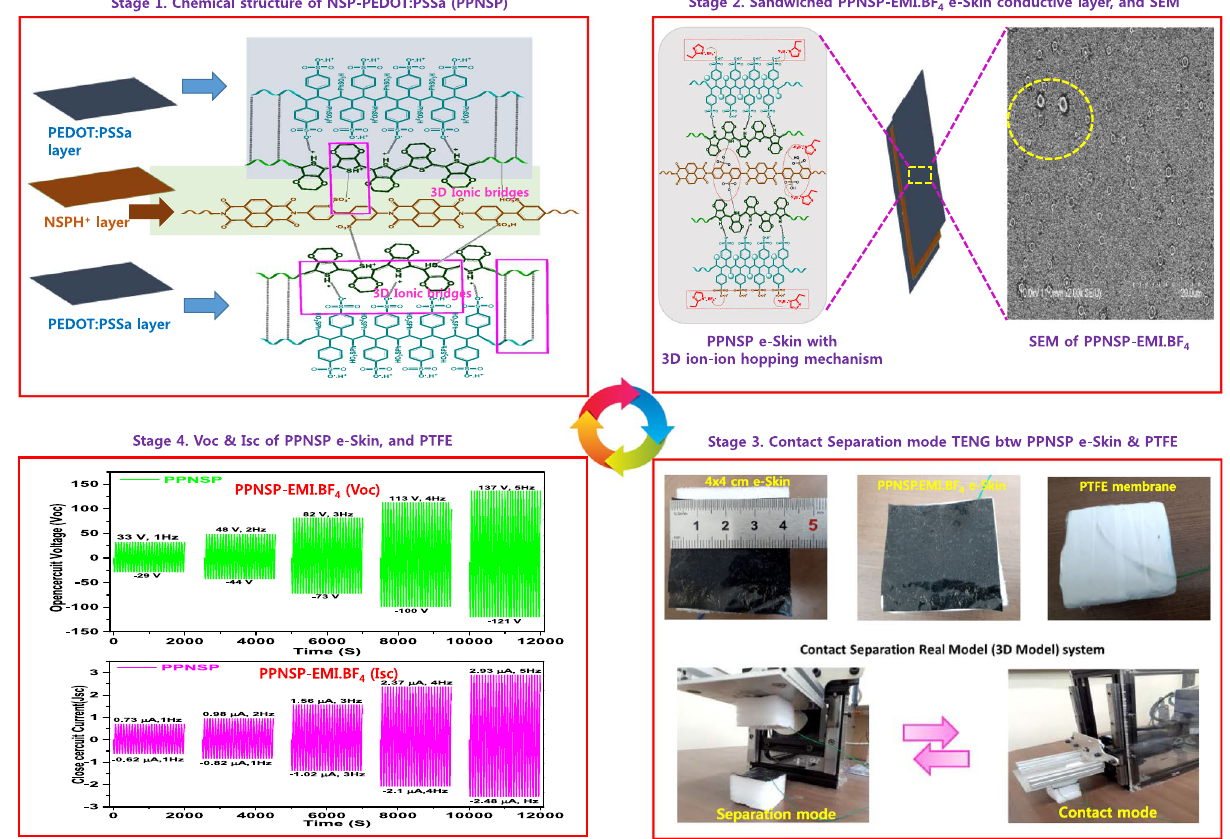
Figure 1. Schematic representation of PPNSP-EMI.BF 4 -PTFE TENG for harvesting energy through ionic electrets and ion-hopping mechanisms. Stage 1. Synthesis of NSP.H + s: PEDOT: PSSa composite film, Stage 2 Fabrication of ionic net-worked conductive composite electronic skin (e-Skin); Stage 3. Size of (4 cm × 4 cm) PPNSP.EMI.BF 4 e-skin and PTFE, and vertical contact separation mode TENG; Stage 4. The Voc and Jsc of conductive PPNSP-EMI.BF 4 -PTFE e-Skin